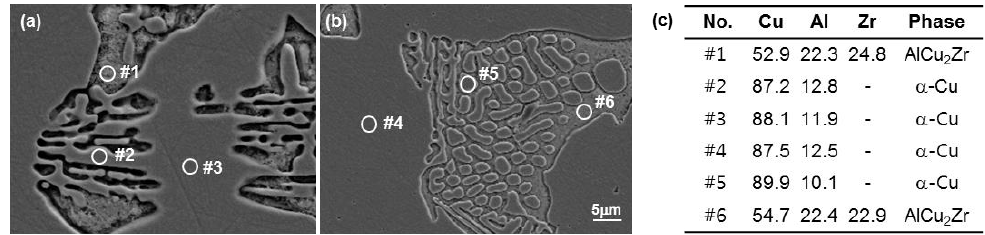
Figure 4. Magnified secondary electron (SE) images of ( a ) as-cast brazing alloy and ( b ) seam brazed at 1000 °C for 0 min, and ( c ) energy-dispersive spectrometer (EDS) spot quantitative analysis (at.%) of the six distinctive phases shown in Figure 3a,b.